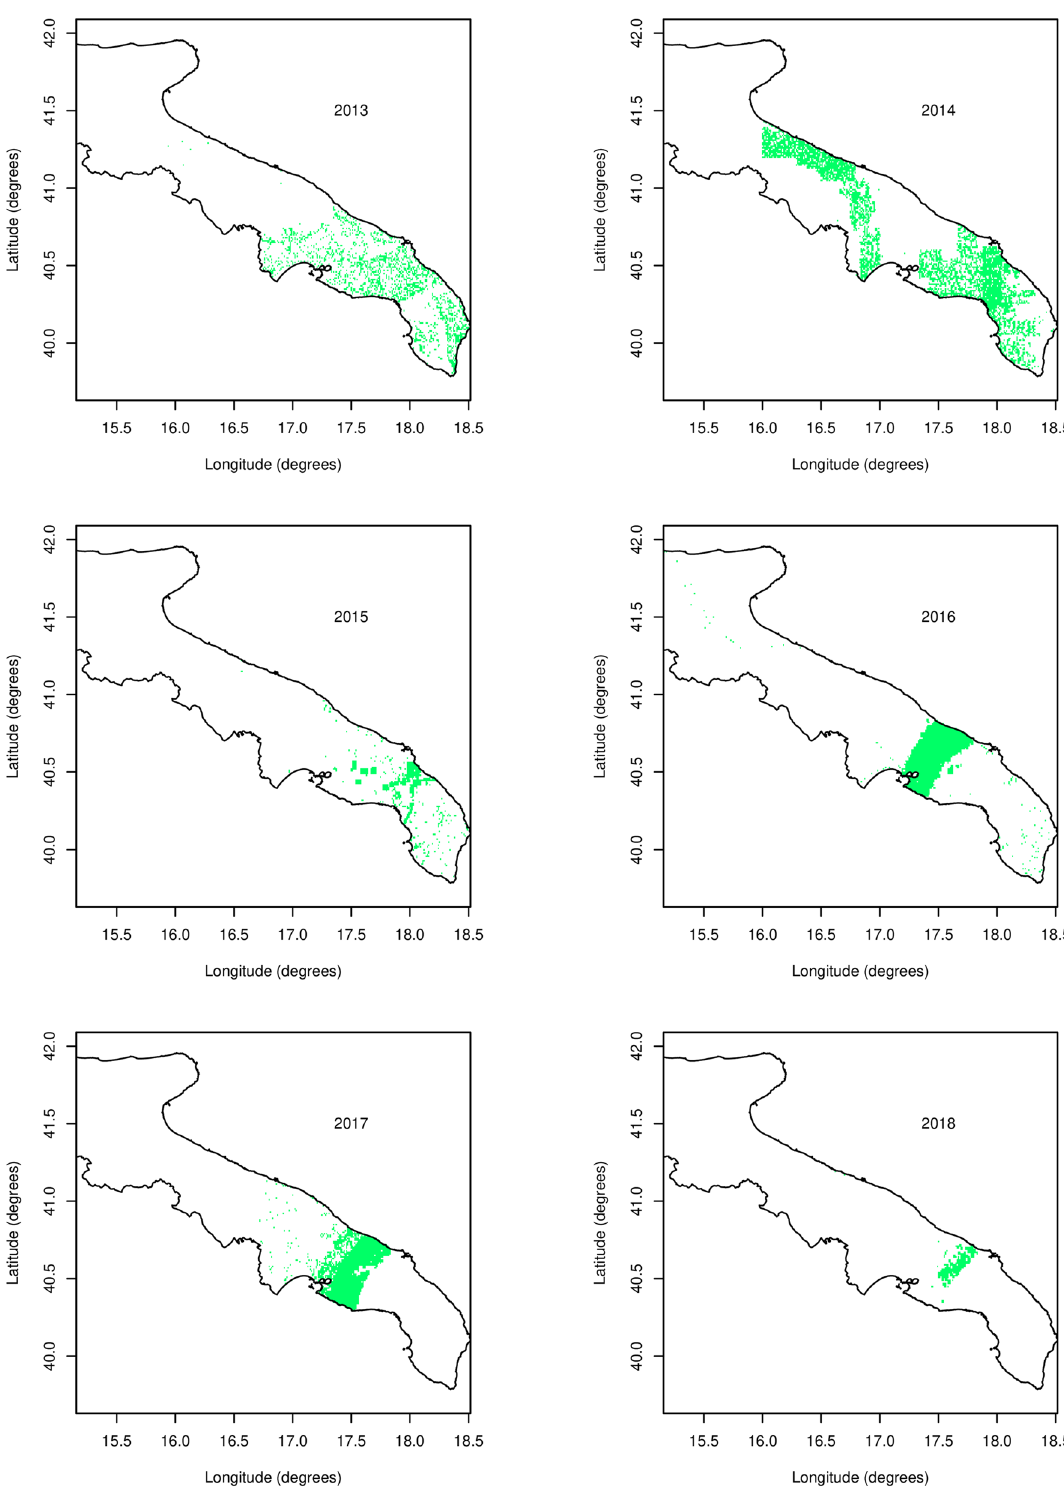
Figure 2. The sampling pattern in the Puglia region per year, 2013–2018. Green spots are locations where samples have been taken. Sampling was done by the Apulian Regional Phytosanitary Service. Latitude and Longitude are expressed in